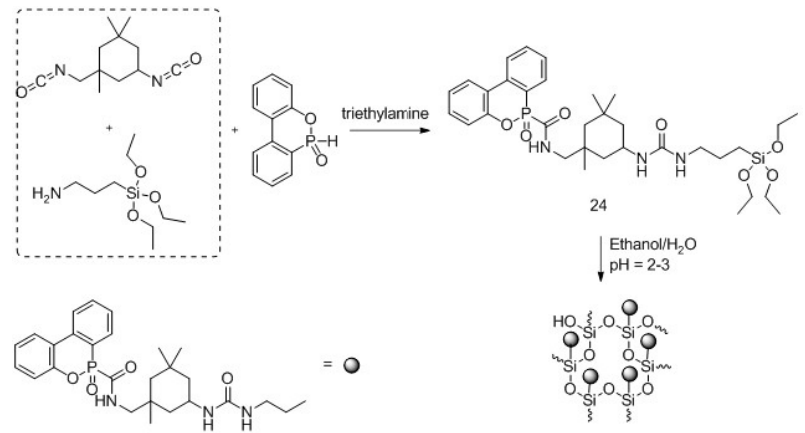
Figure 16. Representative synthesis of hybrid organic-inorganic flame retardant precursor ( 24 ) and its hydrolysis.